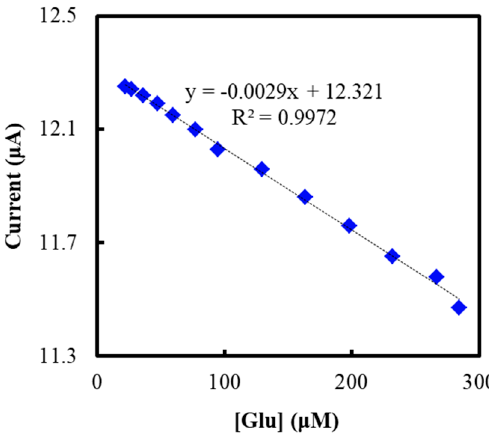
Figure 7. Current responses of the NF/GluOx/IL/mPEG-fMWCNTs modified GCE upon real human plasma samples with different concentration of glucose .